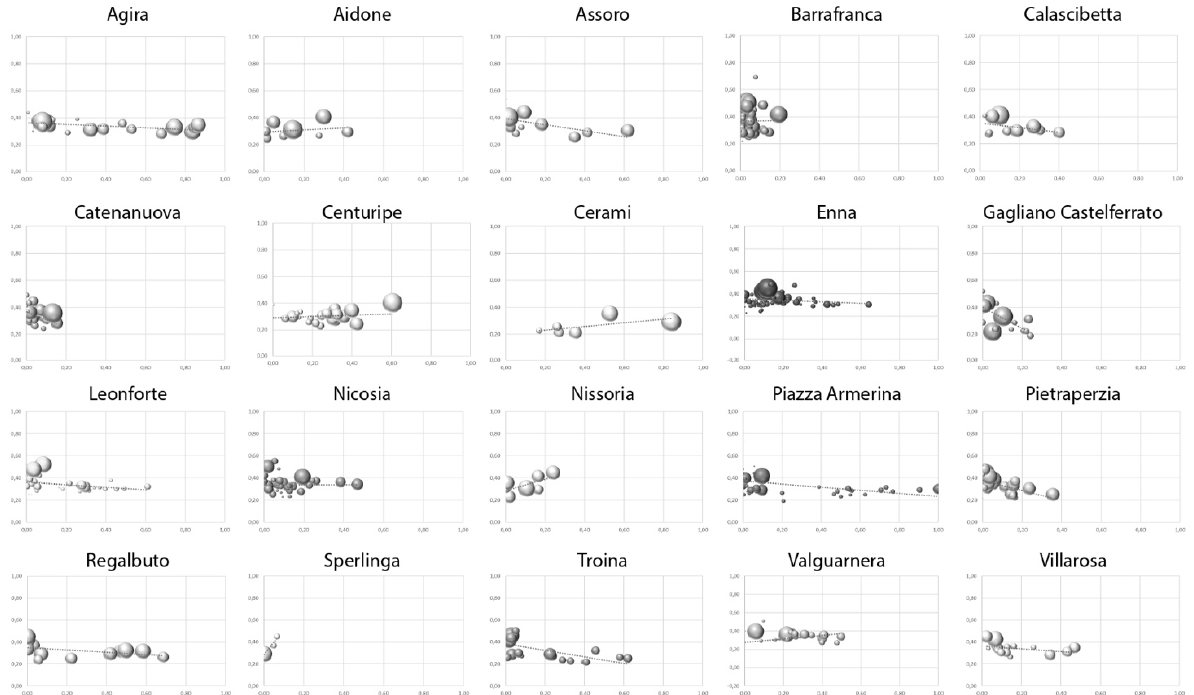
Figure 9. Each graph shows all the Census Sections of the corresponding municipality. On the abscissa is the testimonial value, on the ordinate is the average size of families and the bubble size measures the surface area of the Census Section.